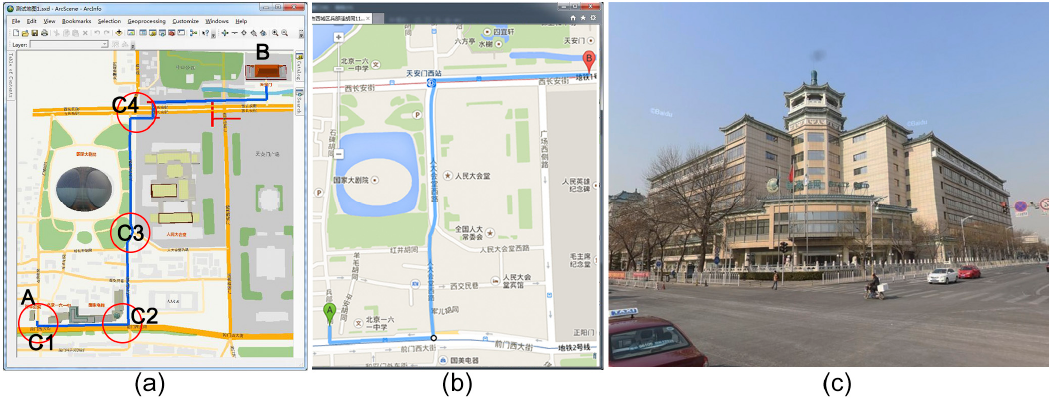
Figure 3. Experiment stimuli: ( a ) designed 3D map; ( b ) 2D Google map; and ( c ) a screenshot of the street view at the Crossroad 2 (C2). The blue line from A to B indicates the predefined route. C1, C2 and C4 are decision points that require re-orientation. C3 is a T-junction and requires confirmation of the route. Refer to Figure 1 for English version of Chinese names of landmarks and streets in the map. The blue line indicates the pre-defined route. The picture of the street view was from Baidu Map (http://ditu.baidu.com) under free license for non-commercial use.